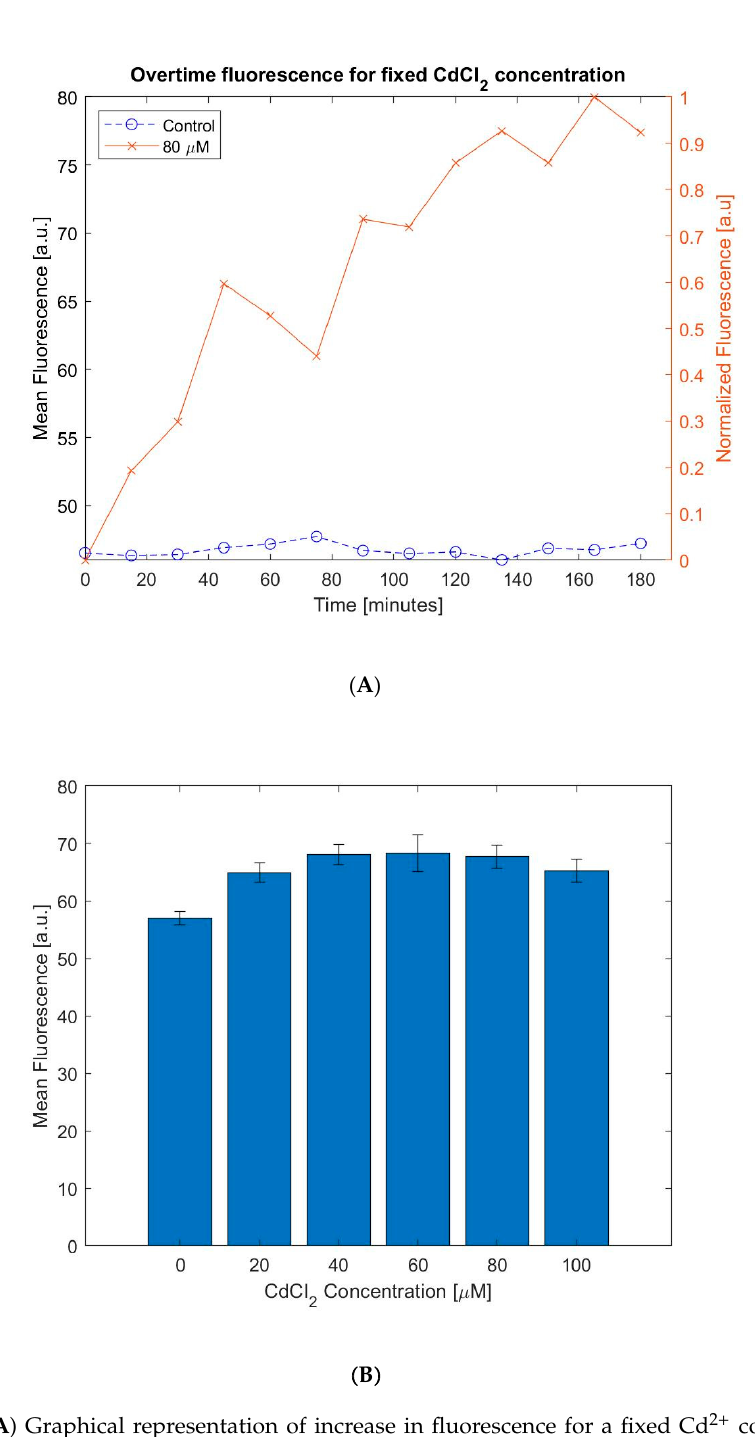
Figure 8. ( A ) Graphical representation of increase in fluorescence for a fixed Cd 2 + concentration. Figure 8: ( A ) Graphical representation of increase in fluorescence for a fixed Cd 2+ concentration. ( B ) ( B ) Graph showing the measurement of fluorescence of the proposed device for di ff erent concentrations Graph showing the measurement of fluorescence of the proposed device for different concentrations of Cd 2 + of Cd 2+ .